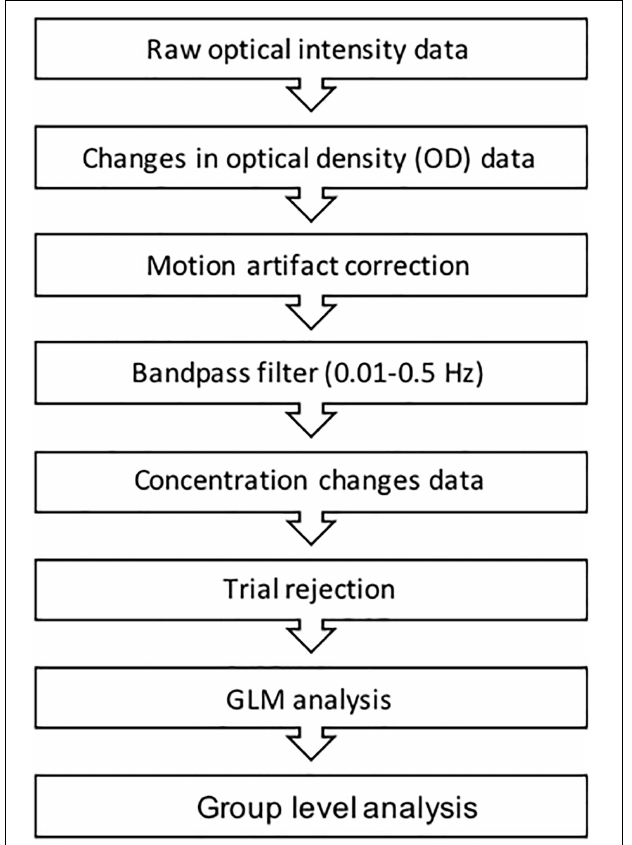
FIGURE 5 | The figure above represents a common fNIRS data processing procedure.